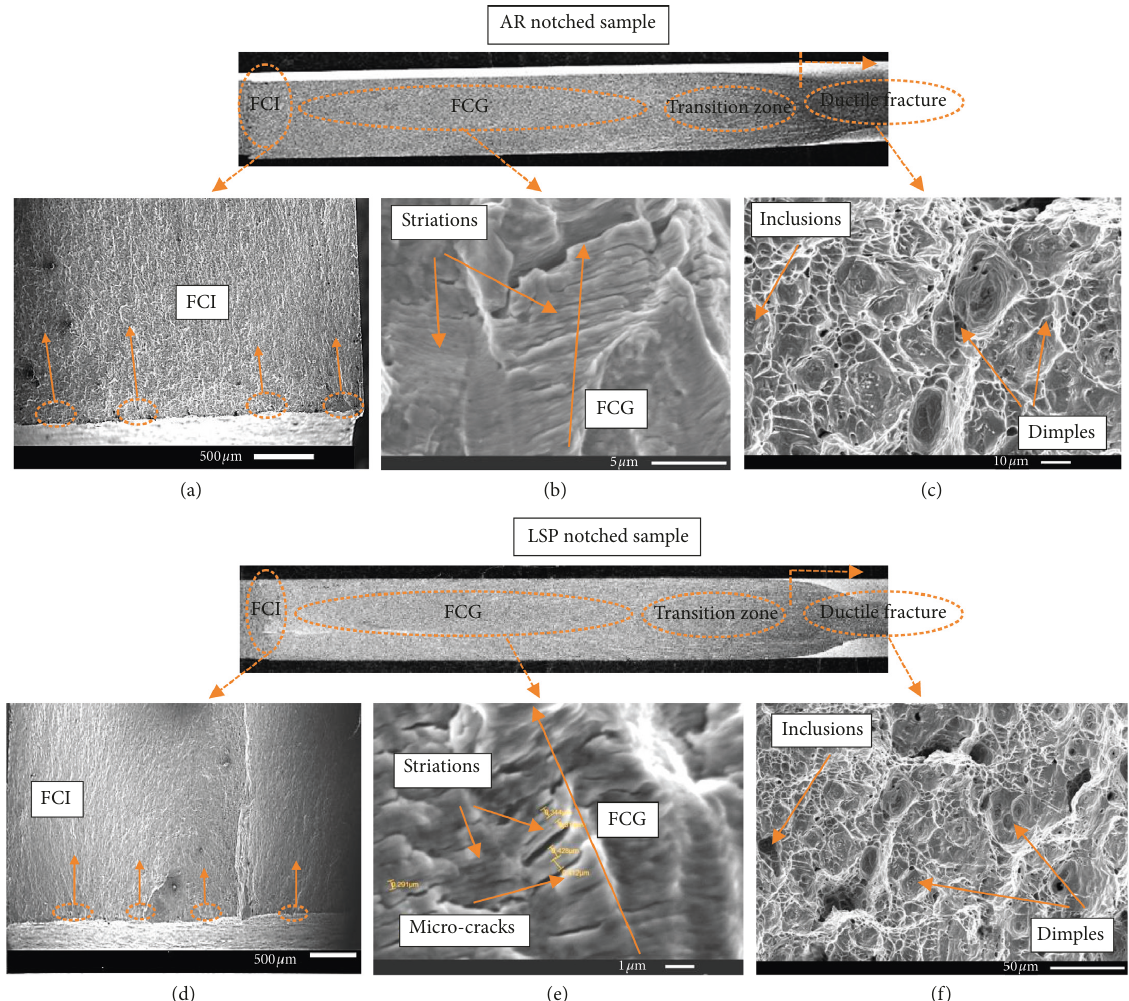
Figure 15: Fracture surfaces of the 4mm thick specimen: (a, d) crack initiation, (b, e) fatigue striation, and (c, f) final rupture. Figure 15 is reproduced from Granados-Alejo et al.